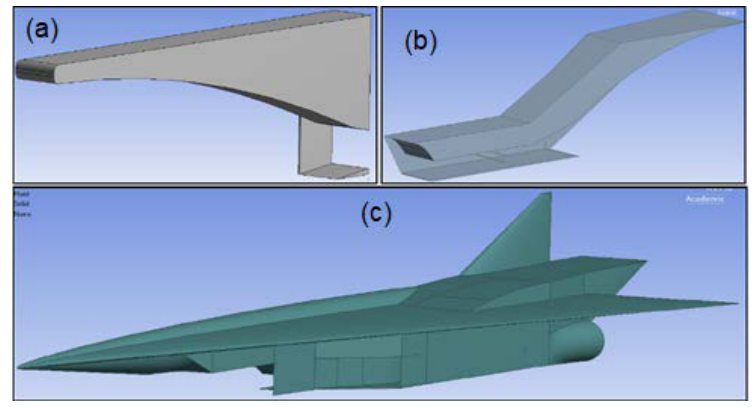
Figure 2. 2D geometries of ( a ) nozzle, ( b ) scramjet engine, and ( c ) aircraft and scramjet engine integration.